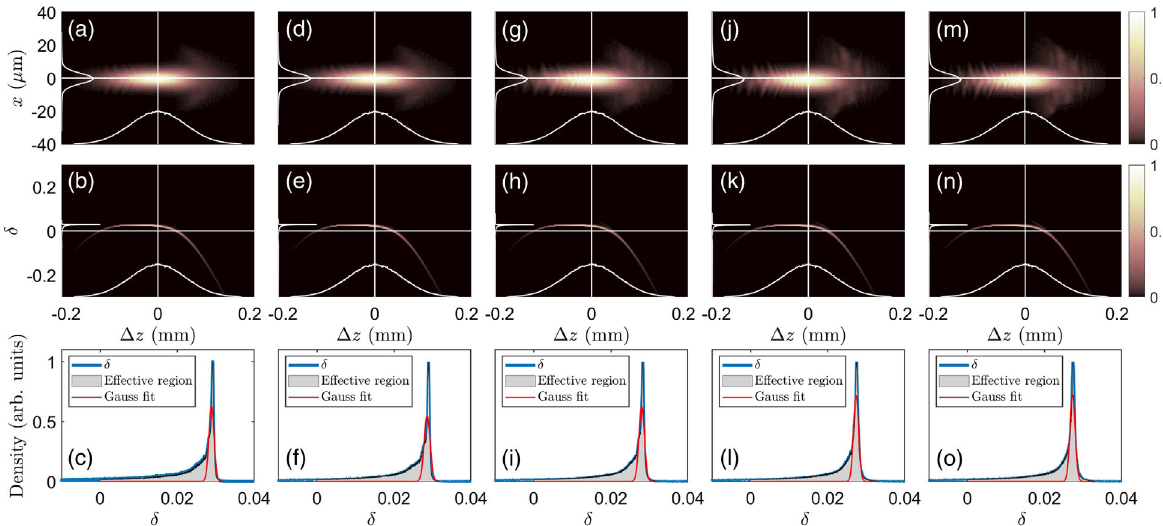
FIG. 24. Beam slice distribution (first row), longitudinal phase space (second row), and fractional energy spread (third row) of the electron beam after propagation through the 5 m plasma source under various conditions. (a – c) Reference case with CSR OFF. (d – f) Case in which CSR is ON but fully suppressed, resulting in zero emittance growth. (g – i) Case in which CSR is ON and not suppressed, resulting in an emittance growth of 11%. (j – l) Case where the CSR-induced emittance growth is 21%. (m-o) Case where the CSR-induced emittance growth is 32%. For the cases where the CSR effect is not suppressed, the centroid and angle are not adjusted. The beam head is placed at positive Δ z and the tail at negative Δ z